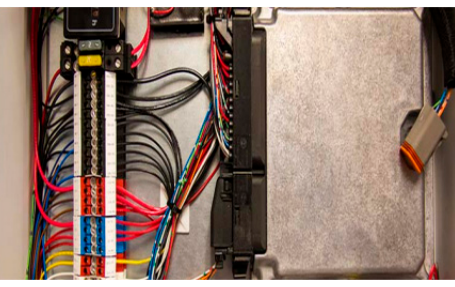
Figure 29. Field-Ready Controller. Reprinted with permission from ref. [12]. Copyright 2021 Double L Industries.